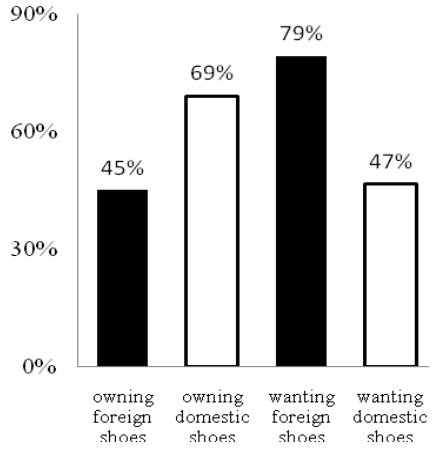
Figure 2: Percentage of ownership and purchase intention of foreign and domestic sports shoes Table 2: Considerations for buying cell phones and